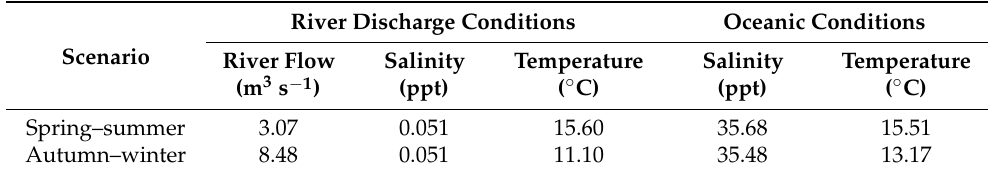
Table 2. Average values of river discharges and thermohaline conditions during spring–summer and autumn–winter